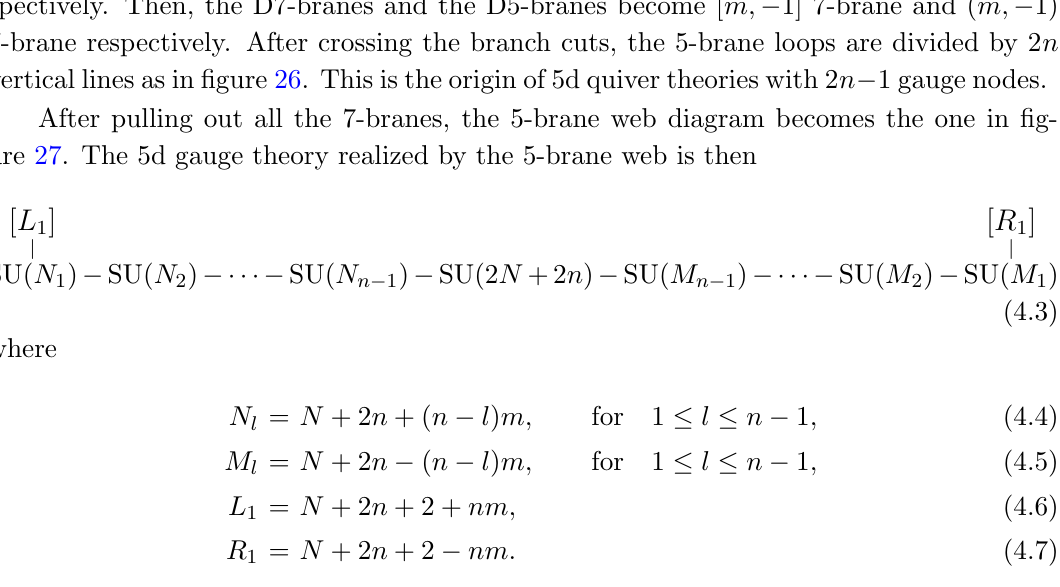
Figure 25 . The motion of the branch cuts of B ; C and X realized by moving some amount of D5-branes and D7-branes. The D5-branes and the D7-branes that move are indicated by arrows in this